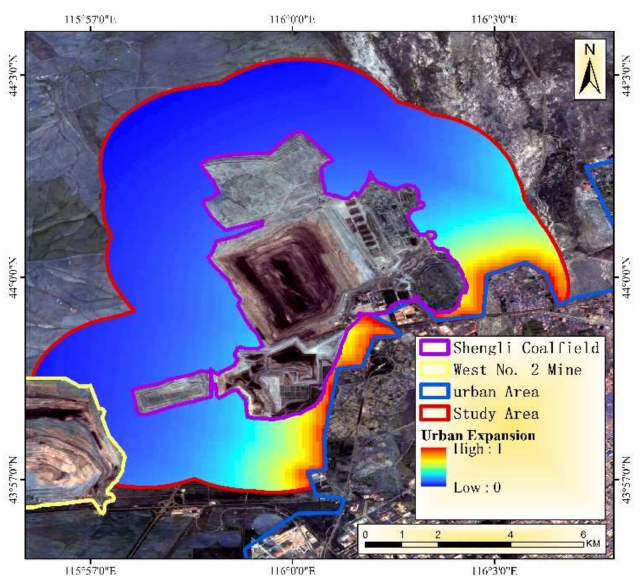
Figure 7. Quantitative results of the urban expansion factor in 2020